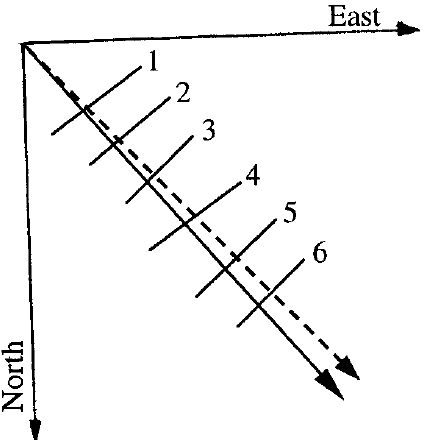
Fig. 8. Comparison of TID observational (dash-line arrow) and cal- culated (solid-line arrow) propagation. The slopes of solid lines are given by wavefront “C” shown in Fig. 3. The numbers correspond to the time series in Fig.